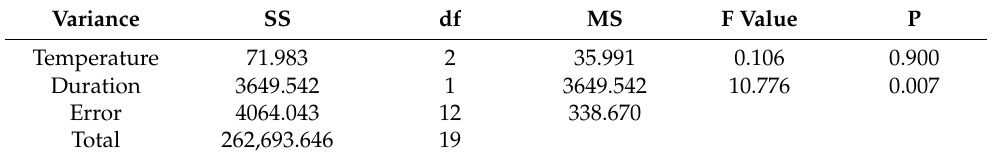
Table 4. GLM univariate analysis of pollen grain diameters of control and high-temperature treatments.